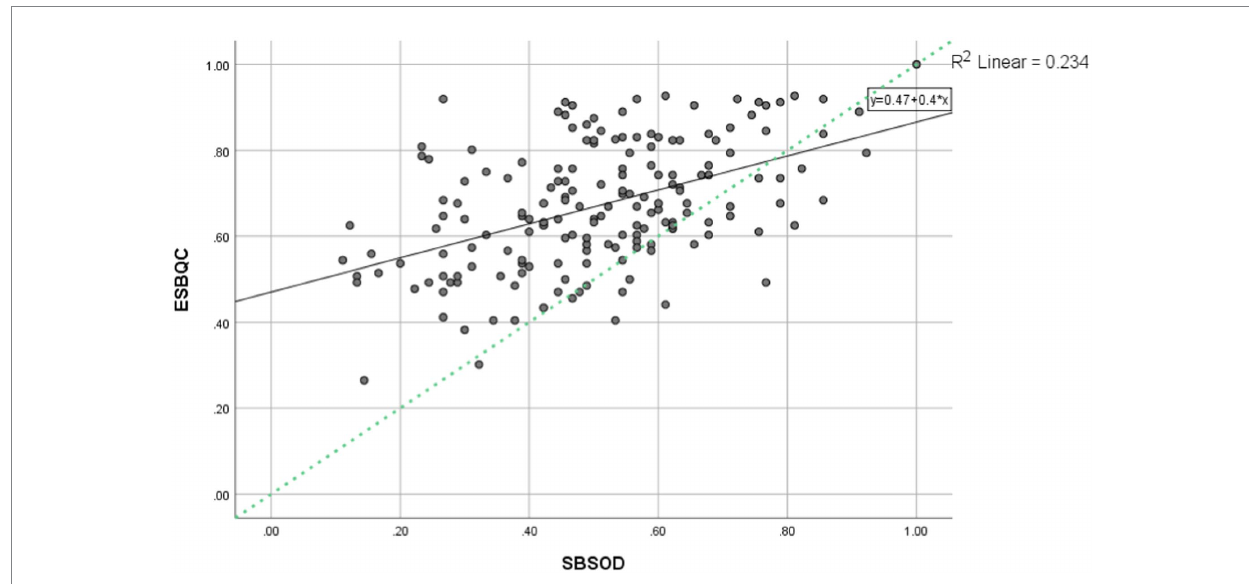
FIGURE 2 The relationship between SBSOD rescaled and ESQBC rescaled. The black solid line shows the regression line, whereas the green dotted line shows y =